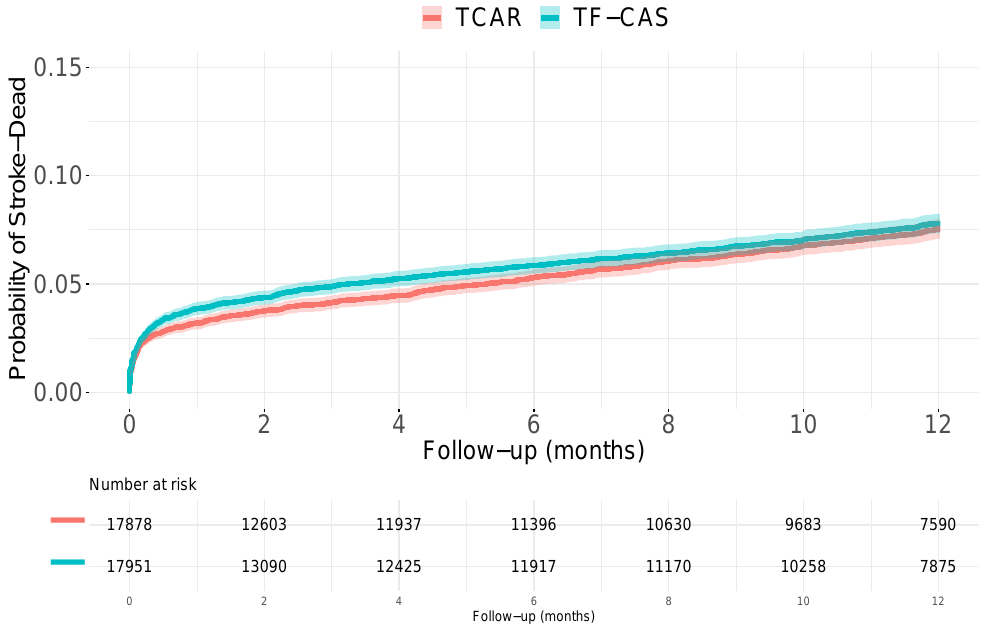
Figure 4. Kaplan–Meier estimations for the cumulative distribution functions of dying or having a stroke in the simulated